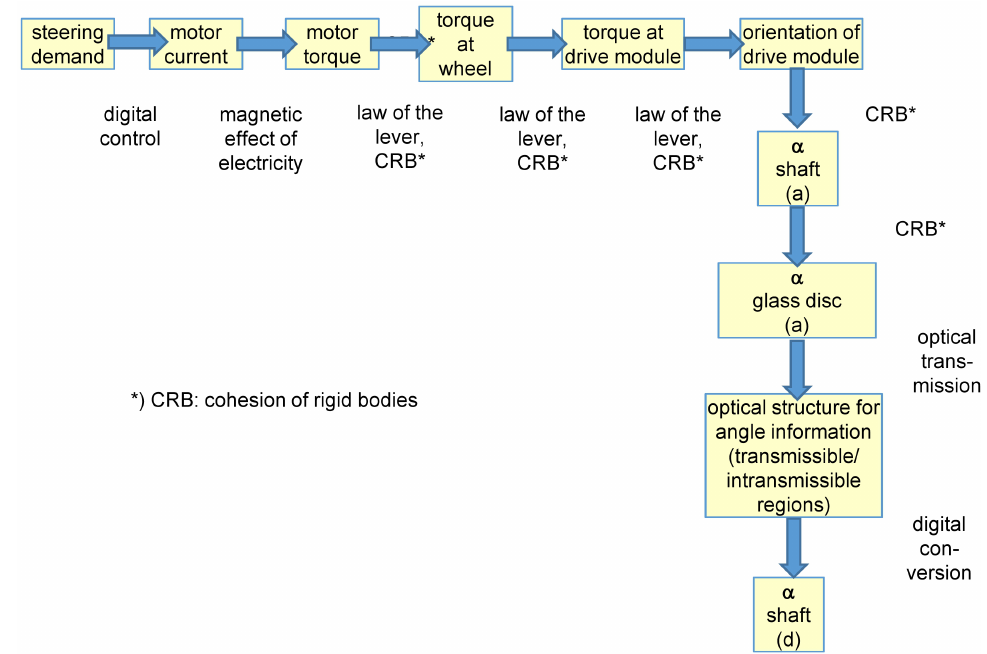
Figure 10. Physical effect chain for the steering system of the